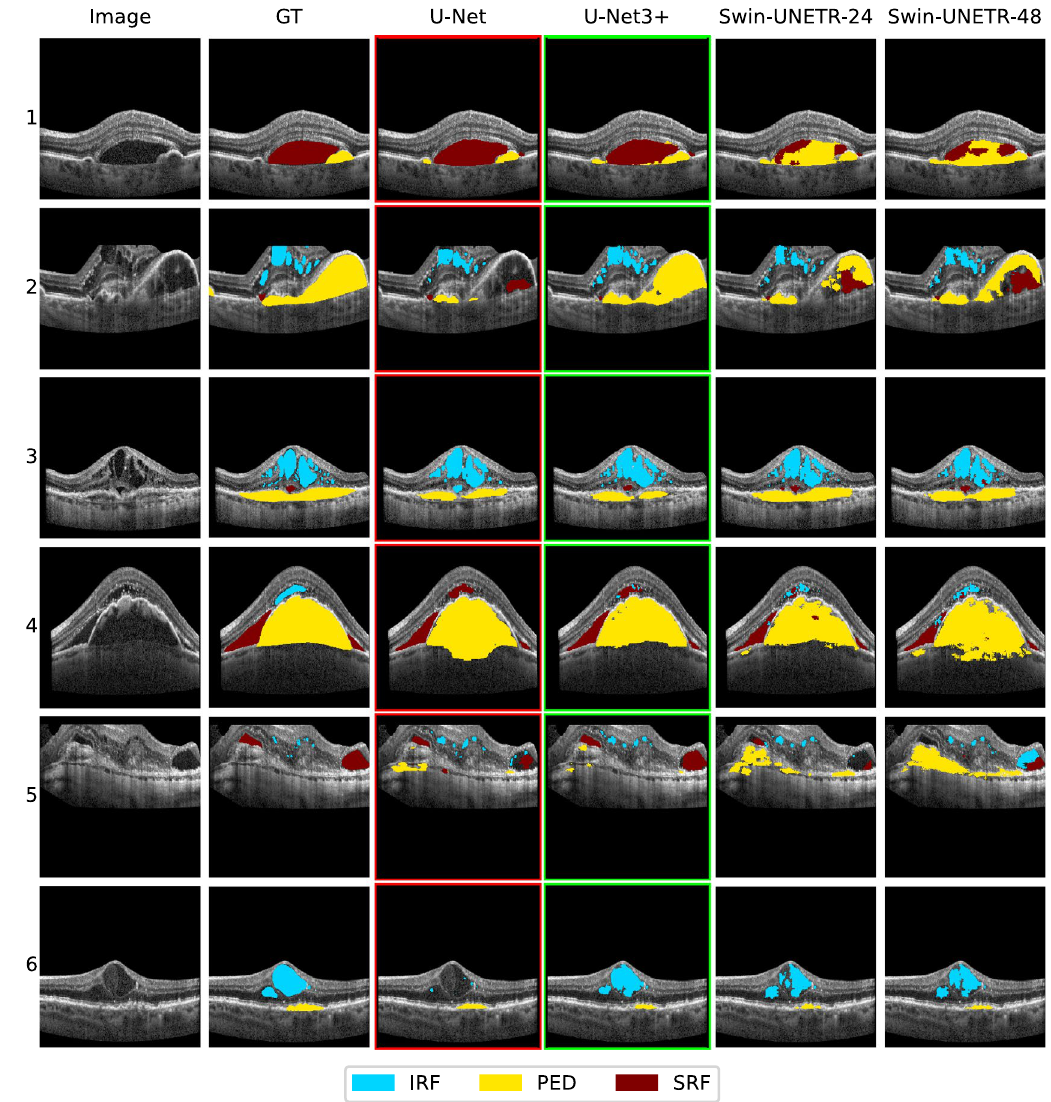
Figure 4. Qualitative model comparison. The columns represent the original image, the reference (GT), and the predictions of the four considered methods from left to right. Each row represents an example case that was selected from the cases with the biggest variance of the mean Dice scores over the folds amongst the four methods. The best and the worst method are highlighted in green and red